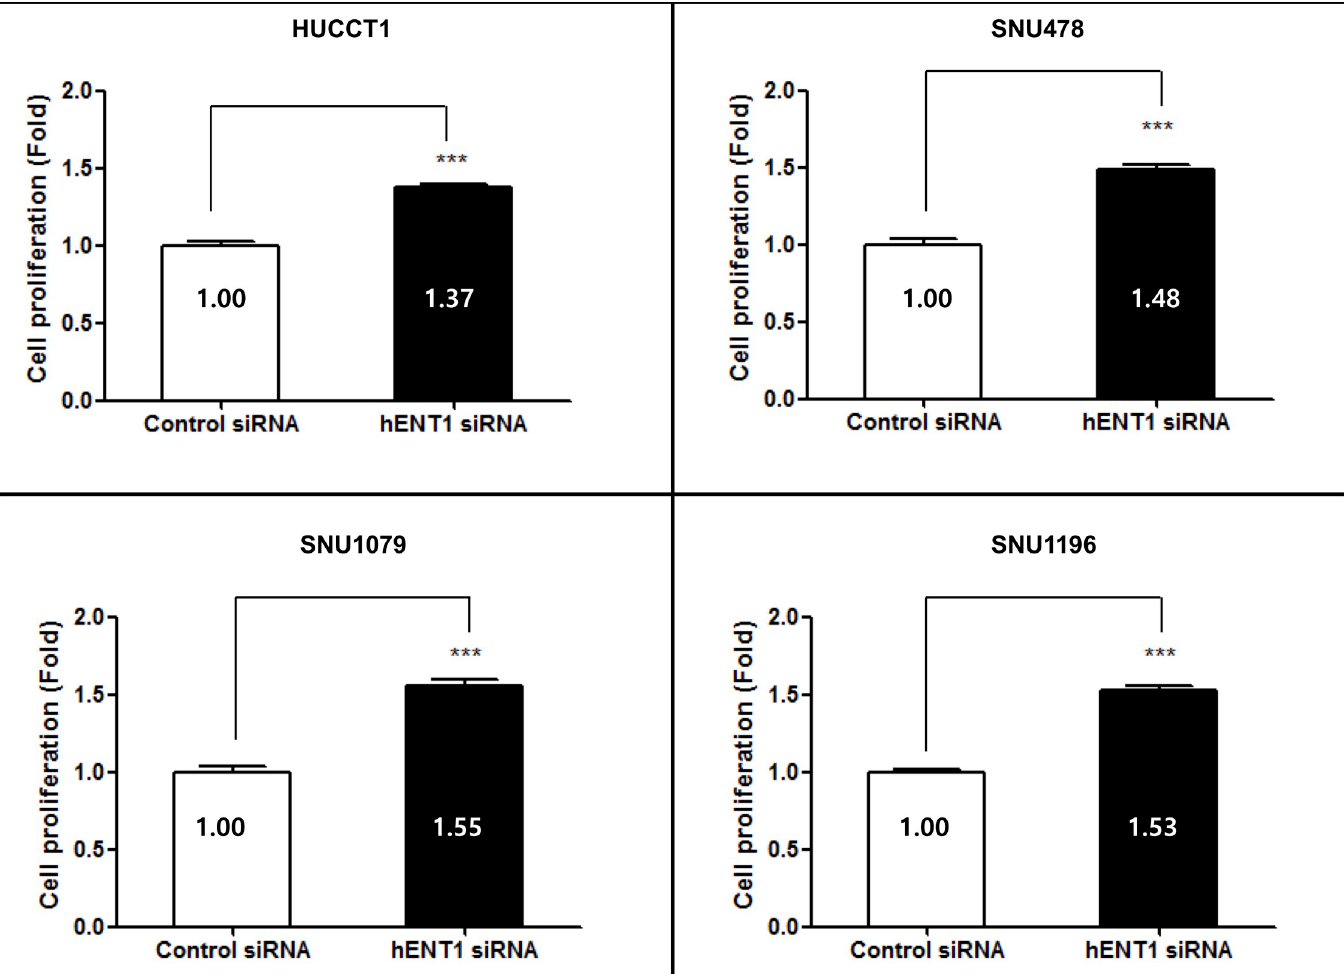
Fig 5. Effects of hENT1 siRNA on gemcitabine sensitivity. During incubation with gemcitabine, cell proliferation at 144 h after treatment with hENT1 siRNA was significantly higher than that after control siRNA treatment.